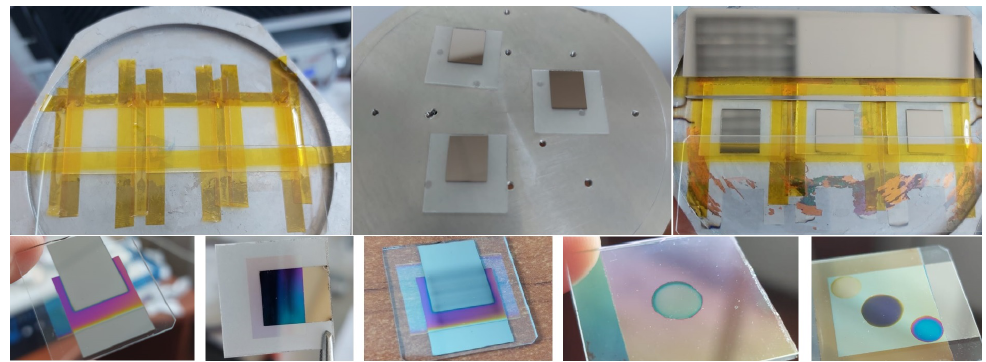
Figure 27. Photos of the process of applying capacitor structures in the experimental study of TiO 2 thin